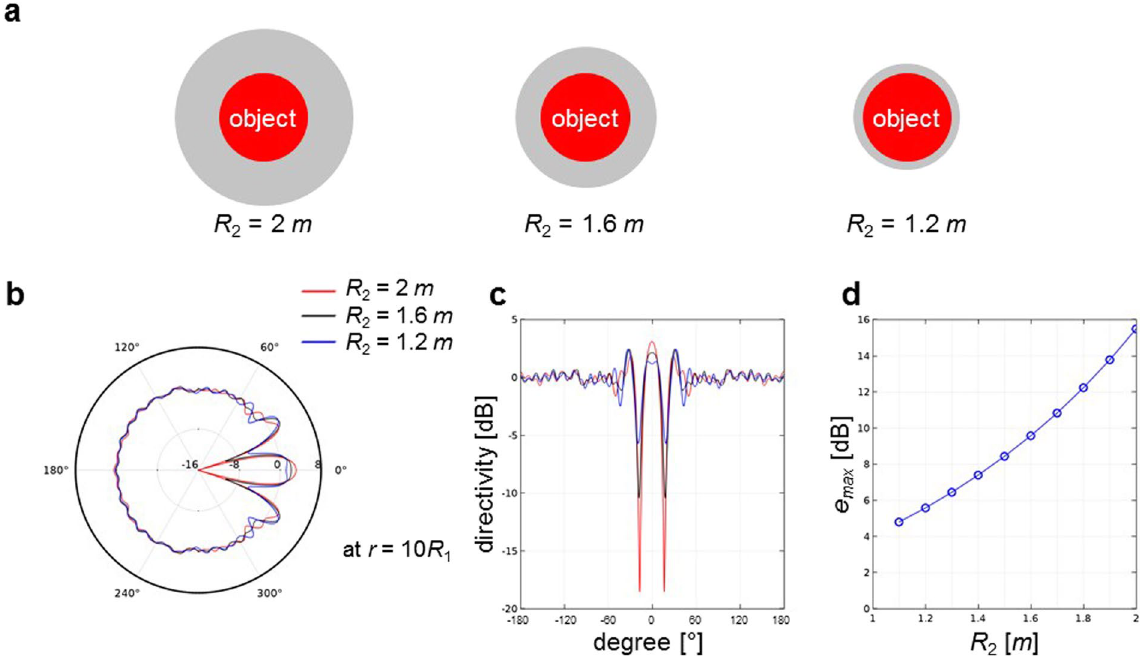
Figure 7. Effect of thickness of the acoustic cloak on scattering pattern. ( a ) Schematics of acoustic cloaks with reduced thickness for R 2 = 2, 1.6, and 1.2 m . ( b ) Polar plot of directivity patterns of the acoustic cloaks with reduced thickness in moving medium for M = 0.2. ( c ) Rectangular plot of directivity patterns of the acoustic cloaks with reduced thickness in moving medium for M = 0.2. The directivity patterns are calculated in dB scale by using equation (5) at r = 10 R 1 . ( d ) Maximal errors calculated by using equation (8) at r = 10 R 1 for various thicknesses of acoustic cloak. As shown in ( b ) and ( c ), the thinner cloak shows less of scattering from the cloak in moving medium. In addition, as clearly shown in ( d ), the scattering decreases as the thickness of acoustic cloak